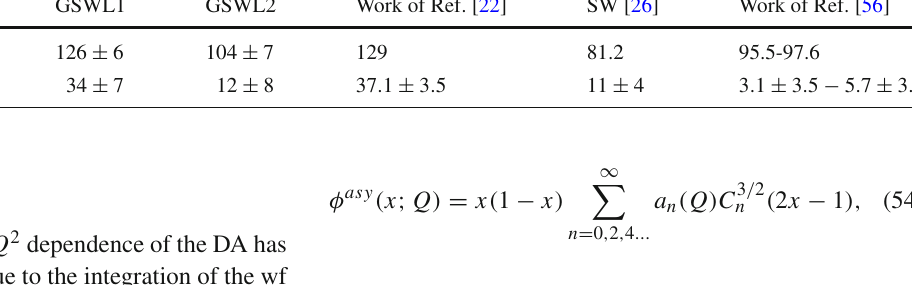
Table 4 Comparison of the pion decay constant between holographic models [26,56] and data [34]. The difference in modulus between the experimental value and the model predictions is display in the last line Data [34] GSWL1 GSWL2 Work of Ref. [22] SW [26] Work of Ref.